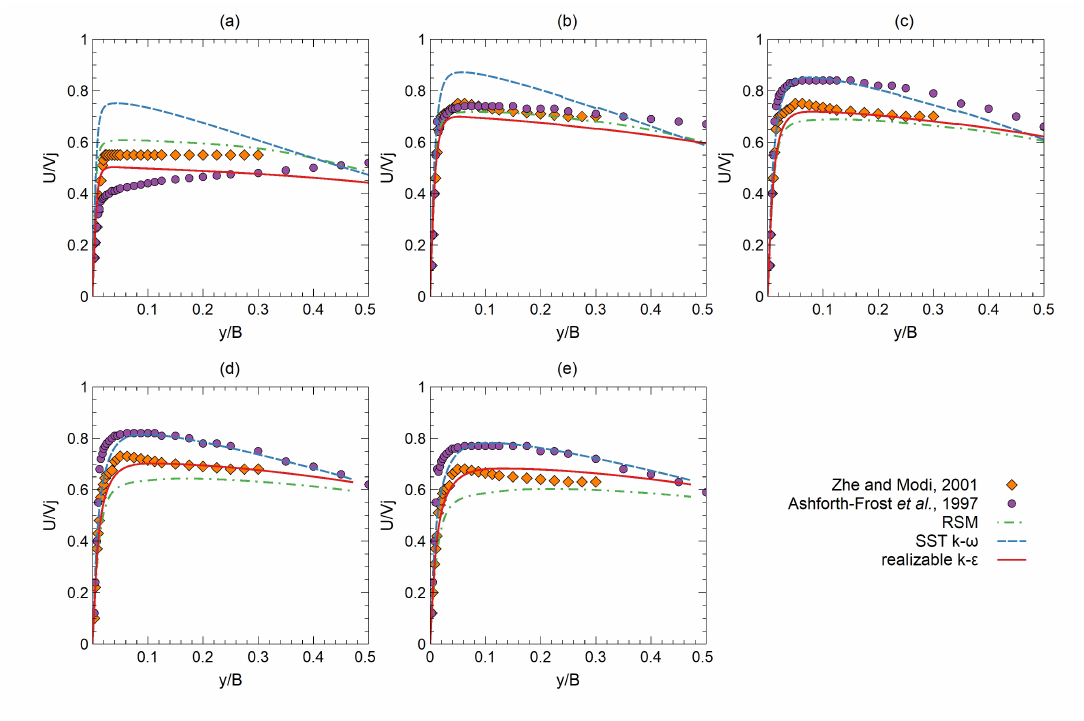
Figure 12. Spanwise velocity profiles for H / B = 9.2 at ( a ) x / B = 1, ( b ) x / B = 2, ( c ) x / B = 3, ( d ) x / B = 4, and ( e ) x / B = 5, compared to reference results reported by Ashforth-Frost et al. [15] and Zhe and Modi